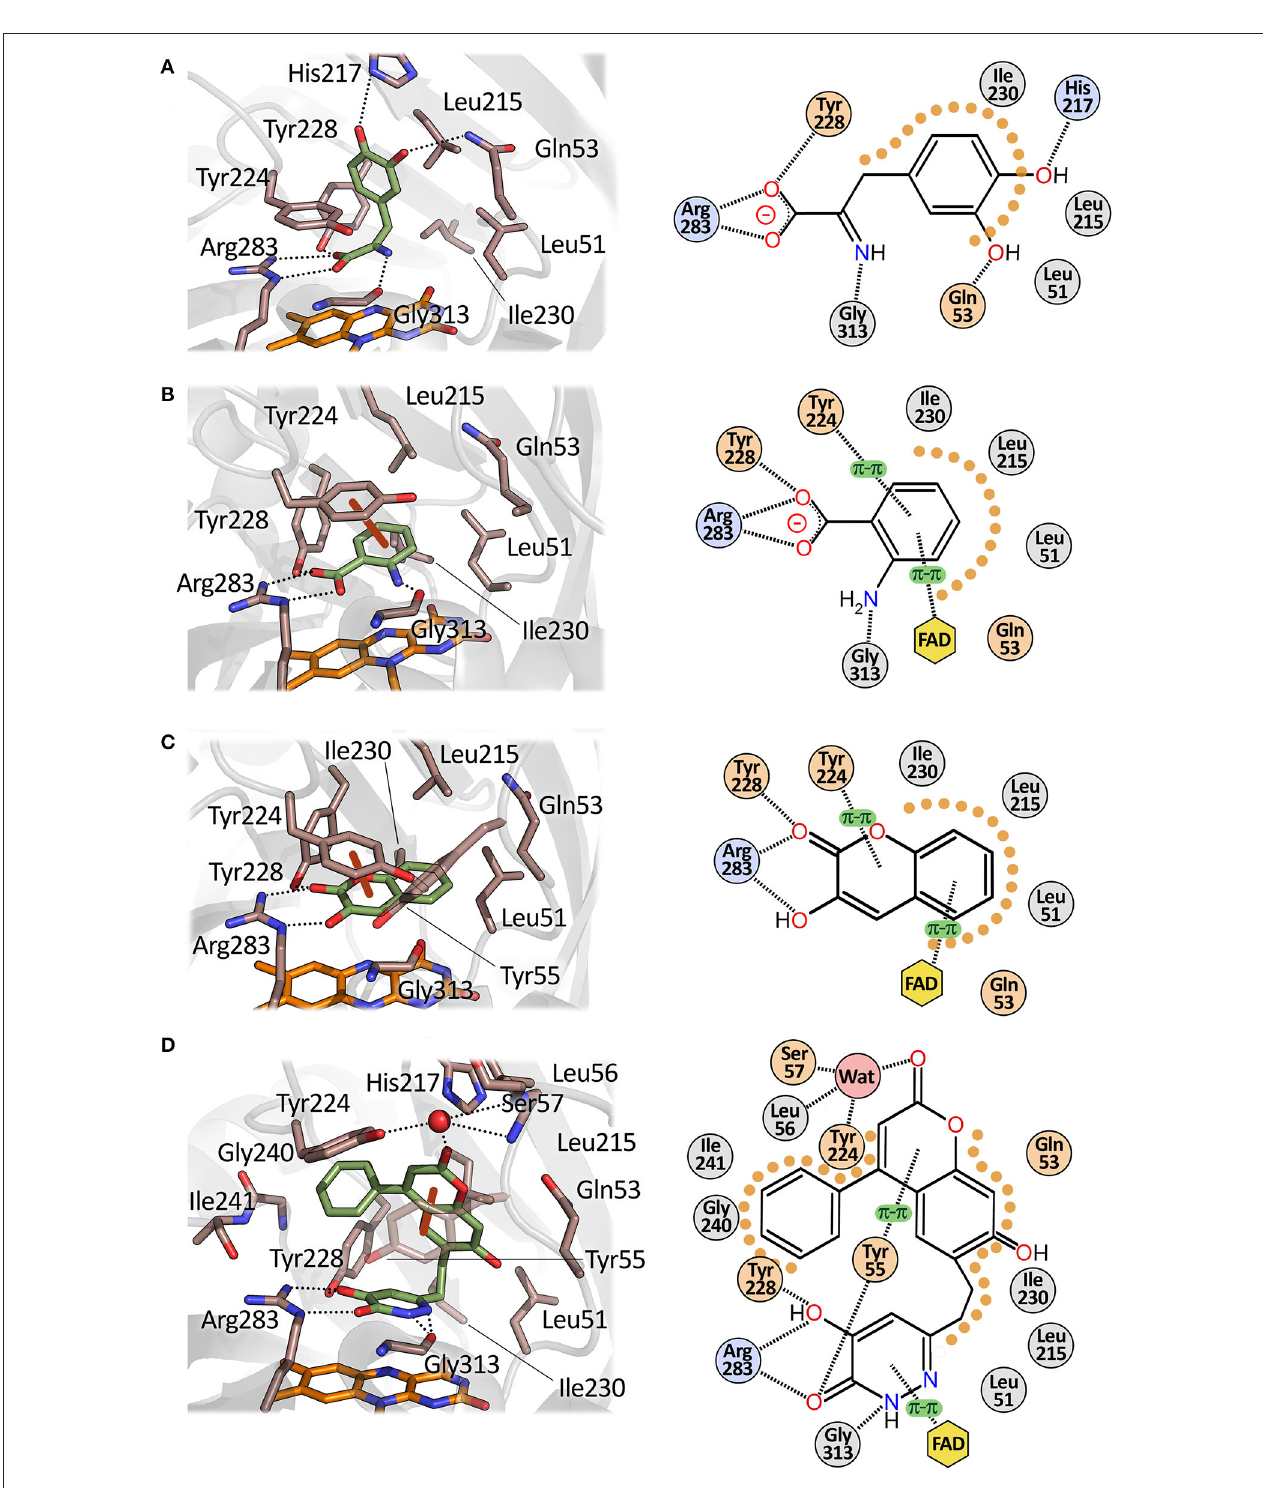
FIGURE 6 | Mode of binding of hDAAO ligands. Human DAAO in complex with (A) imino-DOPA, PDB code 2E82; (B) o-Aminobenzoate, PDB code 2E4A; (C) 3-hydroxy-2H-chromen-2-one, PDB code 3ZNP; (D) 3-(7-hydroxy-2-oxo-4-phenyl-2H-chromen-6-yl)propanoic acid, PDB code 4QFD. Left: detail of the active site. The ligand is in green and the FAD in orange. Dotted lines represent H-bonds and thick brown lines represent π - π interactions. Right: schematic view of ligand-protein interactions. Dotted lines represent H-bonds and π - π interactions. Pale orange dots represent hydrophobic contacts.